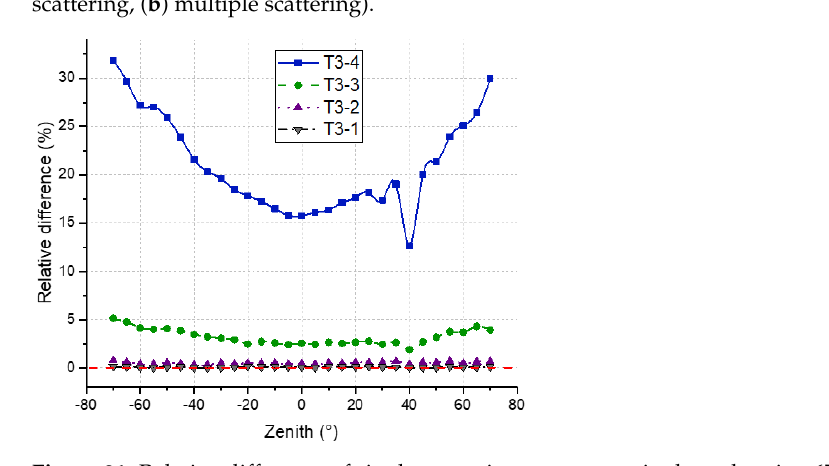
Figure 21. Relative difference of single scattering component in the red region 670 nm for the third stage of growth. stage of